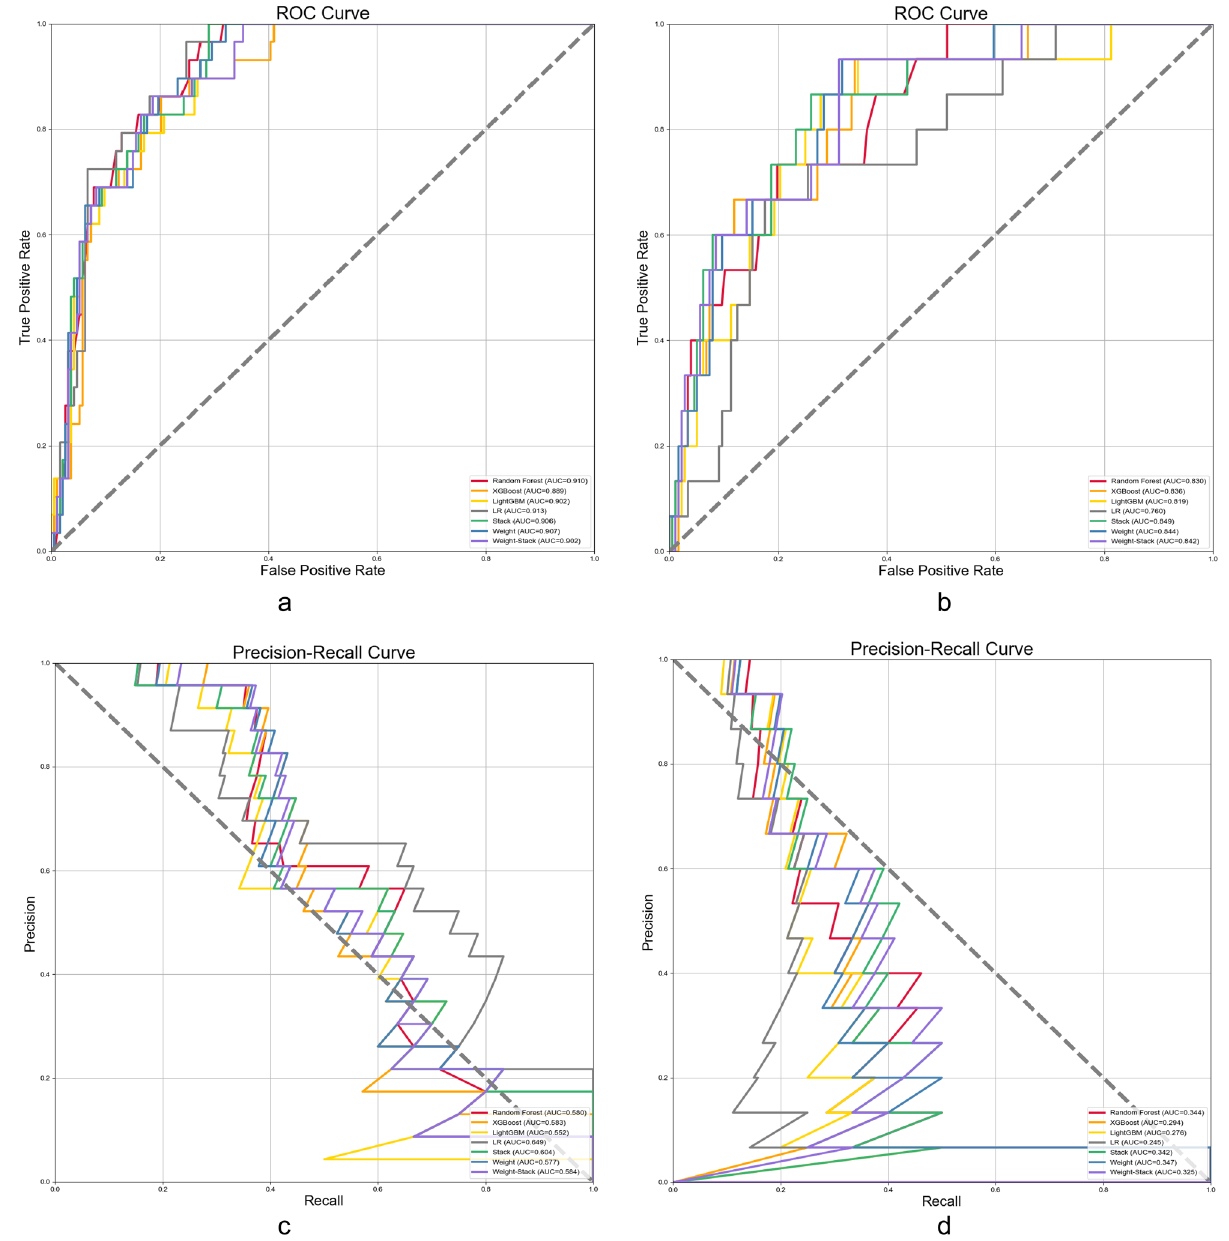
Figure 4. Receiver operating characteristic curves versus precision-recall curves for the conservative treatment group and the surgical treatment group. ( a ) Receiver operating characteristic curves for all models in the conservative treatment group. ( b ) Receiver operating characteristic curves for all models in the surgical treatment group. ( c ) Precision-recall curves for all models in the conservative treatment group. ( d ) Precision- recall curves for all models in the surgical treatment